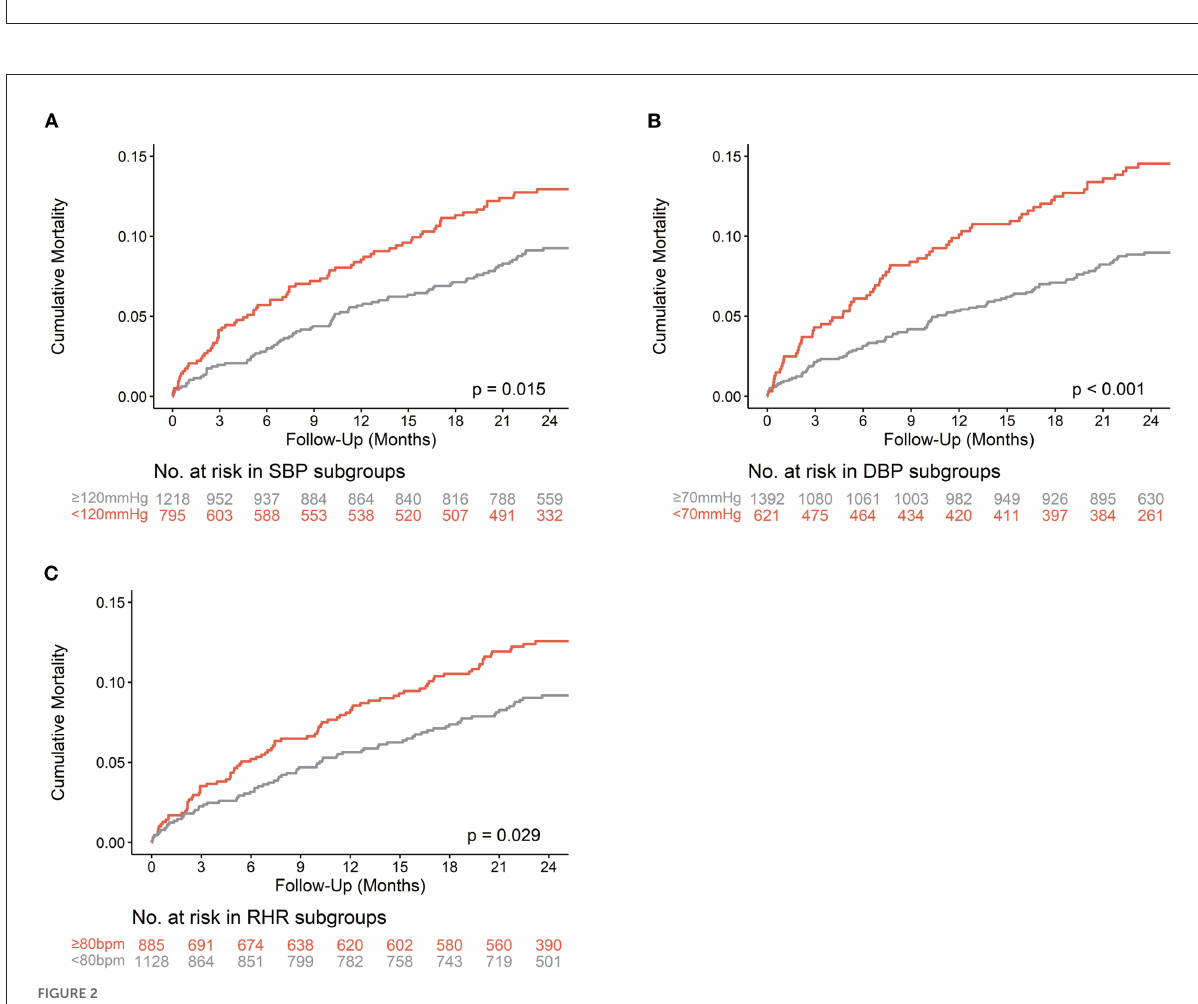
FIGURE1 Associations of SBP, DBP, and RHR with all-cause mortality. Restricted cubic splines demonstrate associations of SBP (A) , DBP (B) , and RHR (C) with all-cause mortality. The splines are presented as hazard ratios (HRs) with 95% confidence intervals. Bpm, beats per minute; DBP, diastolic blood pressure; HR, hazard ratio; RHR, resting heart rate; SBP, systolic blood pressure.